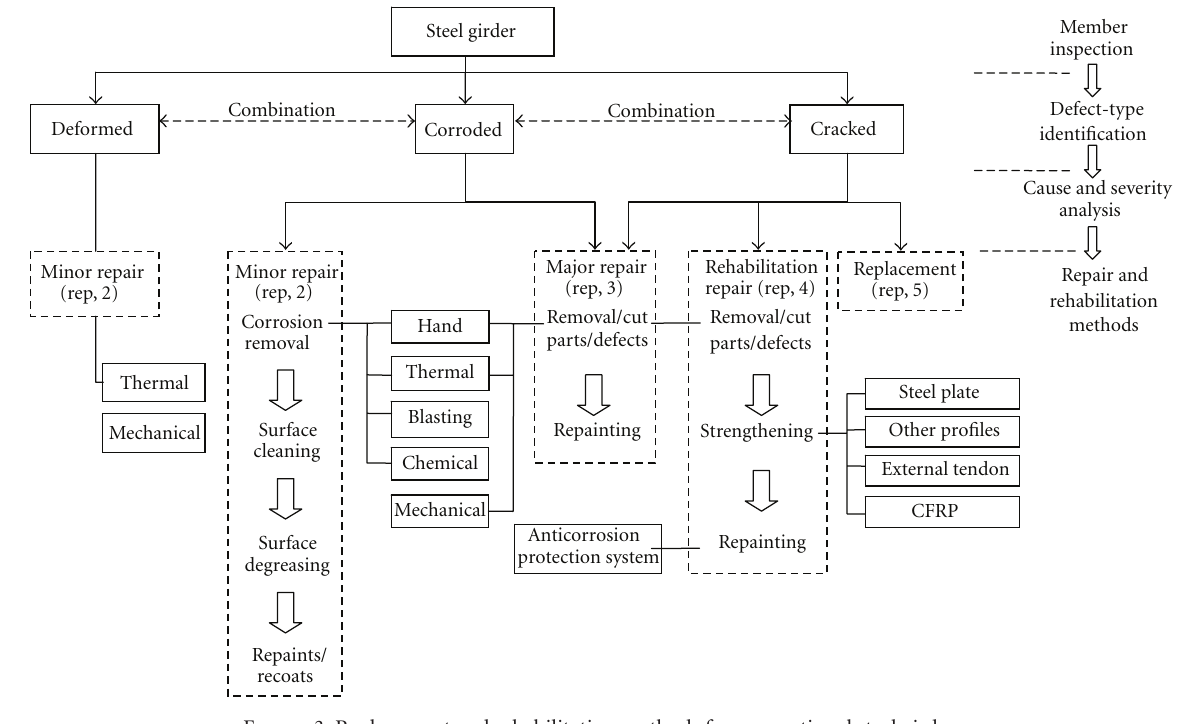
Figure 3: Replacement and rehabilitation methods for conventional steel girder. Table 2: Proposed replacement and rehabilitation action